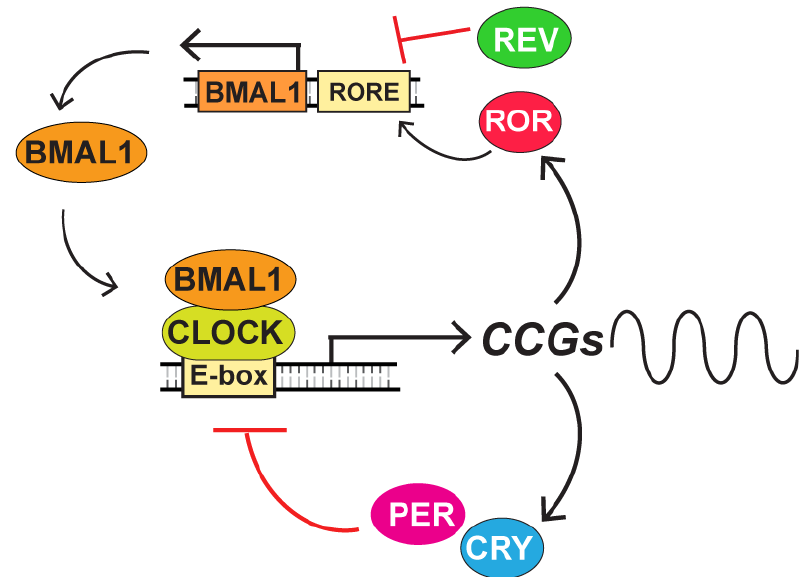
Figure 3. Molecular architecture of the circadian clock transcription machinery. The CLOCK-BMAL1 complex binds to E-box elements in the promoter region of clock-control genes (CCGs). These CCGs include the period (PER) and cryptochrome (CRY) gene products that feed back to inhibit CLOCK-BMAL1 activity. A secondary loop encompassing the retinoic acid-related orphan receptor (ROR) and REV–ERB gene products bind competitively to retinoic acid-related orphan receptor response elements (ROREs) in the BMAL1 promoter to regulate BMAL1 expression.